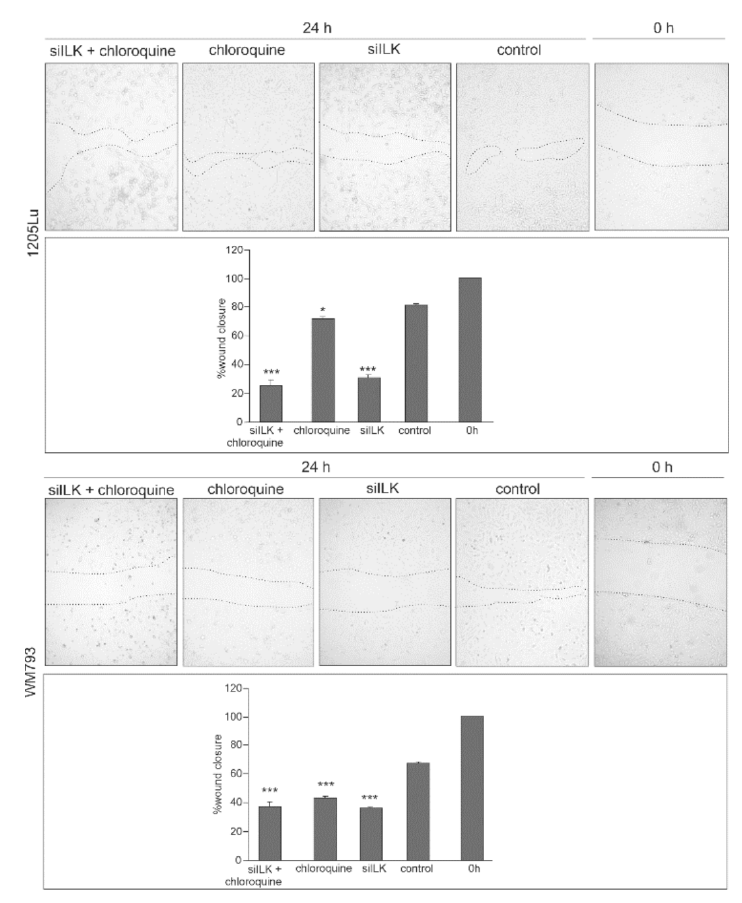
Figure 6. The effect of ILK knock-down and CQ use on in vitro wound healing/migration assay. After 24 h, the confluent cell monolayer was wounded and wound closure was captured by a digital camera connected to the inverted microscope. The assay was repeated thrice in duplicate. The area of wound closure was measured with the use of ImageJ and expressed as the percentage of wound closure. Asterisks indicate significant differences from control cells. The histograms are a quantitative representation of data (mean ± SD) of three independent experiments. Values are denoted as * p < 0.05, ** p < 0.01, and *** p <